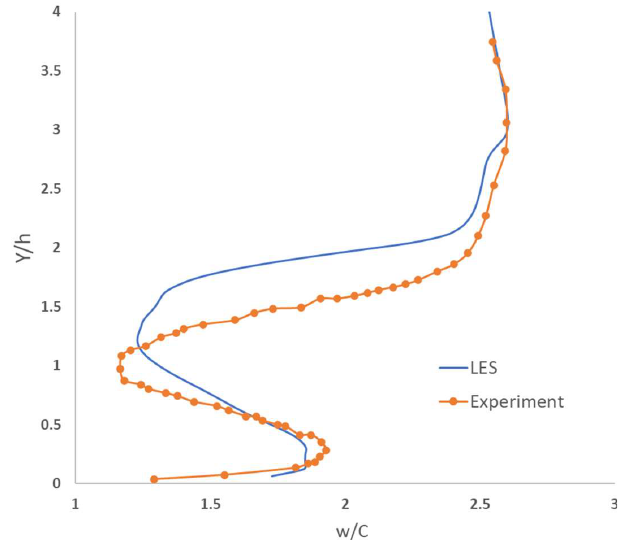
Figure 2. Time-averaged velocity profiles at 𝑥 = 0,𝑧 = 5ℎ .